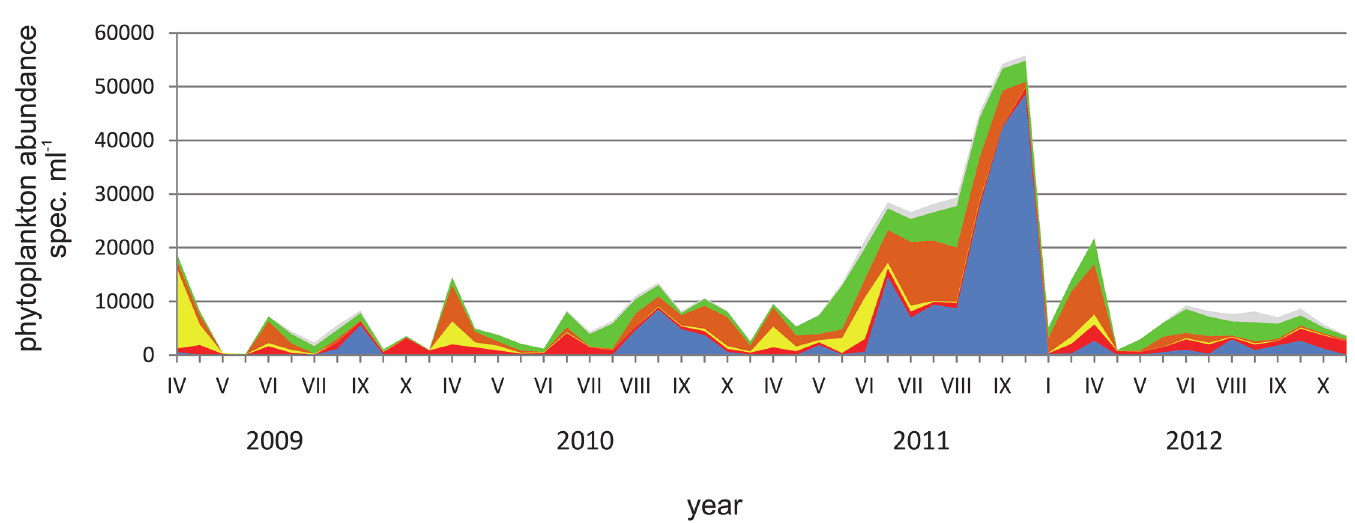
Fig 6. The abundance of phytoplankton groups in the investigated period (an example from the depth of 1